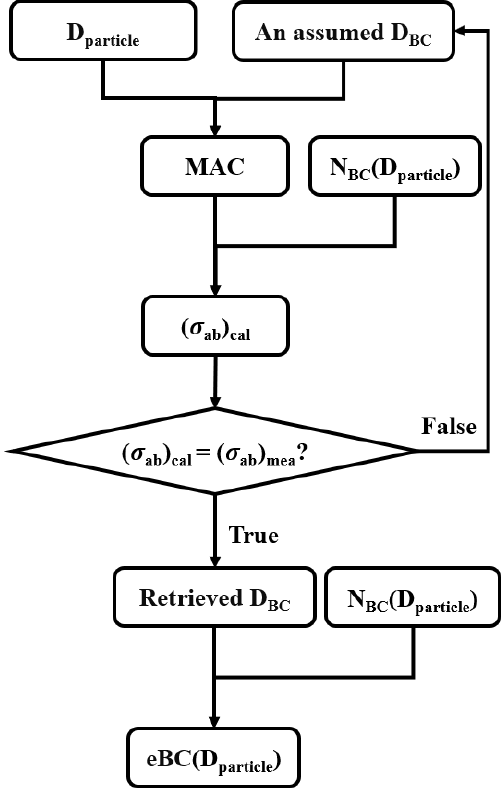
Figure 2. Schematic diagram of the iterative algorithm for retriev- ing the EBC at a fixed particle diameter based on the look-up table of the MAC, particle size and core size. (σ ab ) cal and (σ ab ) mea repre- sent calculated and measured absorption coefficients, respectively. N BC (D particle ) indicates the number concentration of particles con- taining BC at the given D particle